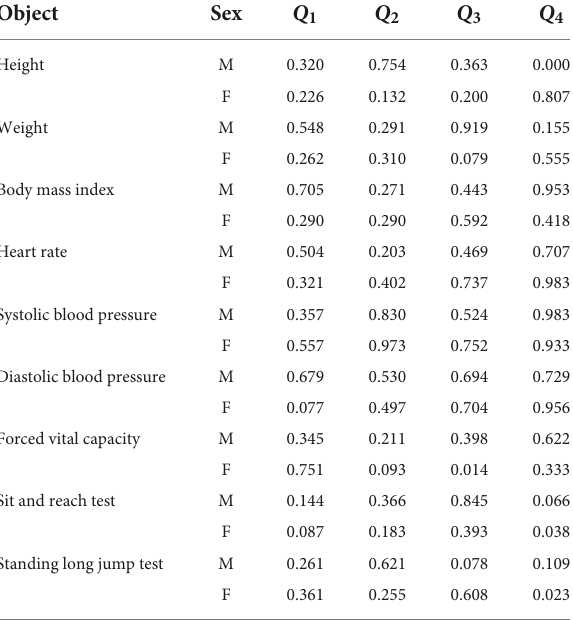
TABLE 3 Summary of the P values for the Q